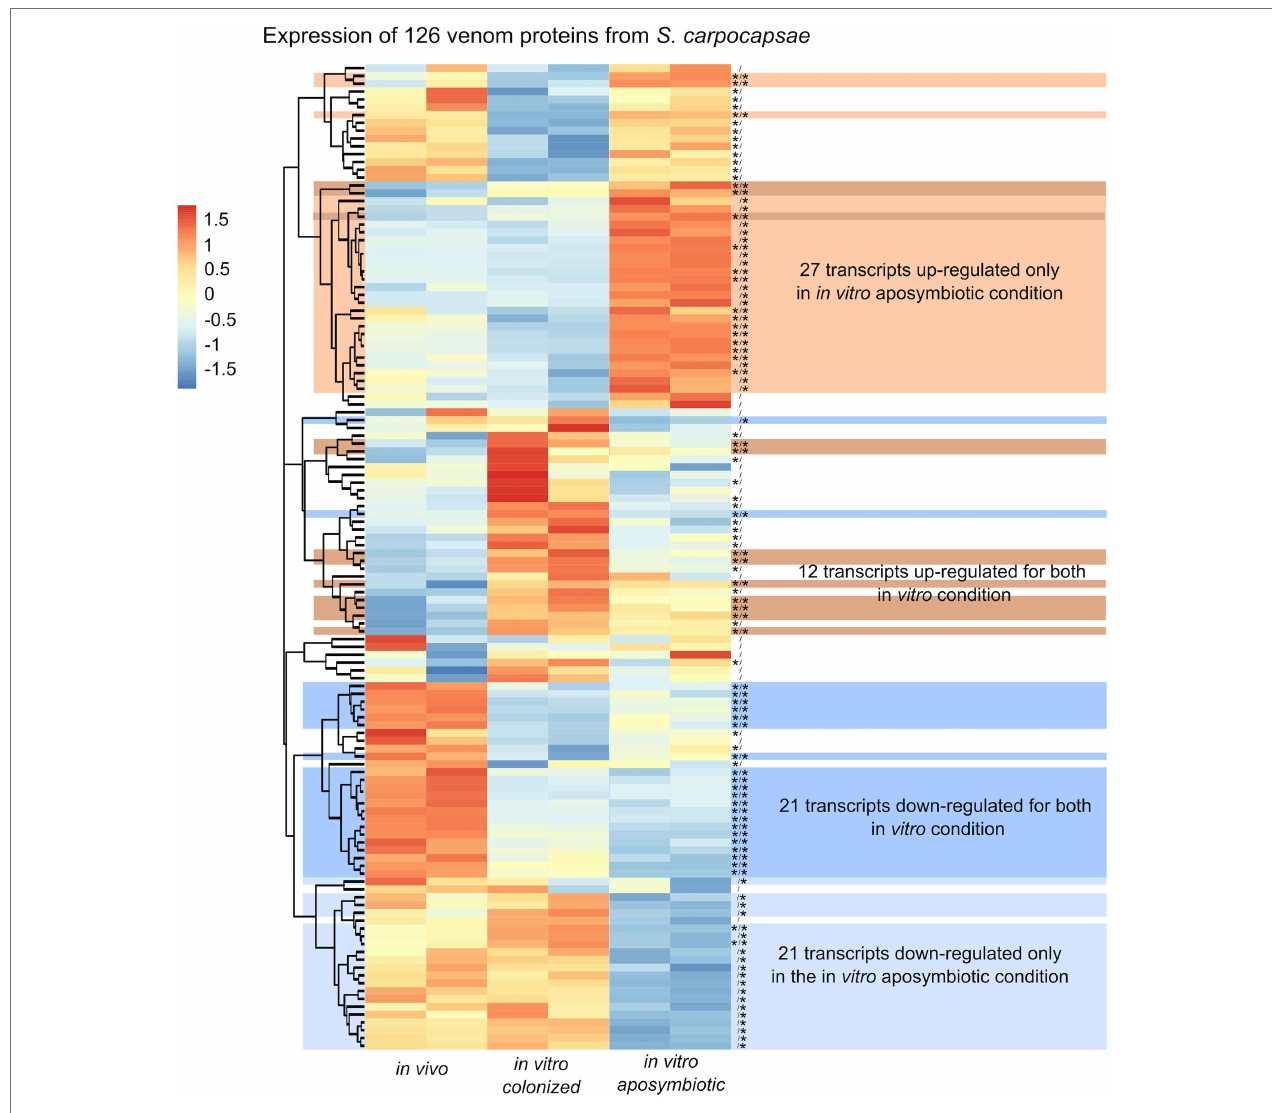
FIGURE 10 | Heatmap of S. carpocapsae transcripts expression homologous to identified S. carpocapsae venom proteins by pheatmap. On the right side of the heatmap supplementary information are indicated: significance of differentially expression based on cuffdiff and edgeR (* for significantly different or bank for not significant), first value for the in vitro colonized rearing condition and the second value for the in vitro aposymbiotic rearing condition; group of transcript associated with differential expression only in the in vitro aposymbiotic reared nematodes or for both in vitro (colonized and aposymbiotic) reared